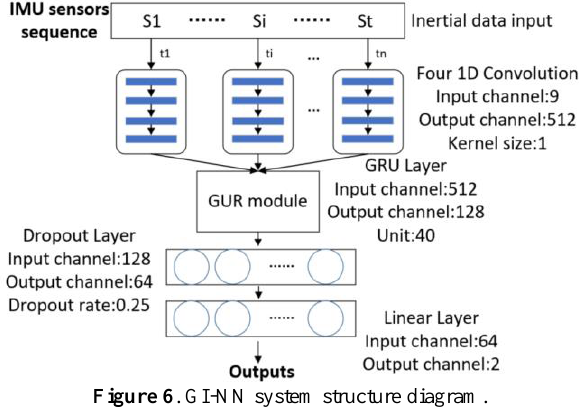
Figure 6 . GI-NN system structure diagram.